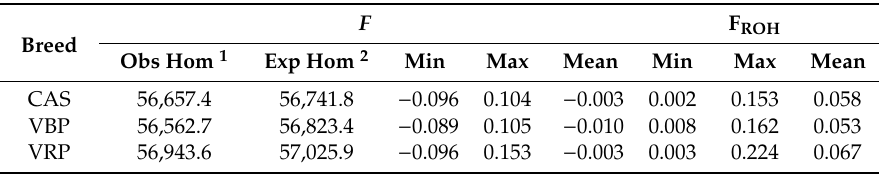
Table 6. Descriptive statistics for F and F ROH